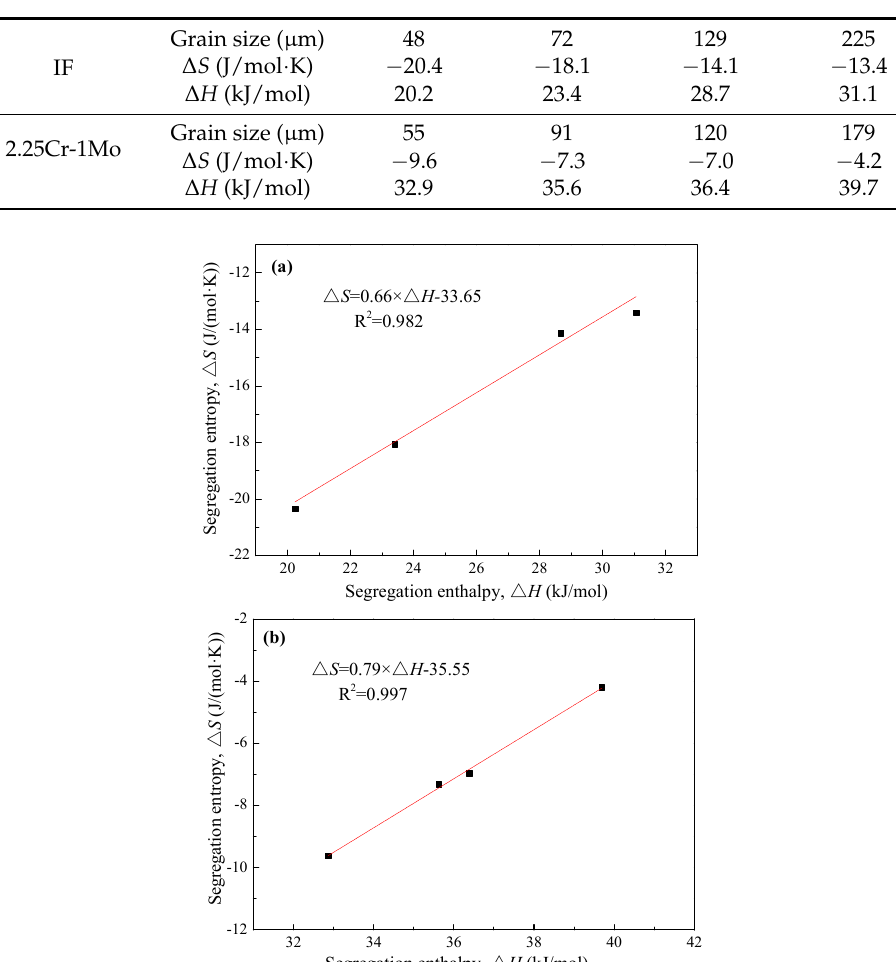
Table 3. Phosphorus segregation enthalpies and entropies in IF and 2.25Cr-1Mo steels with different grain sizes.